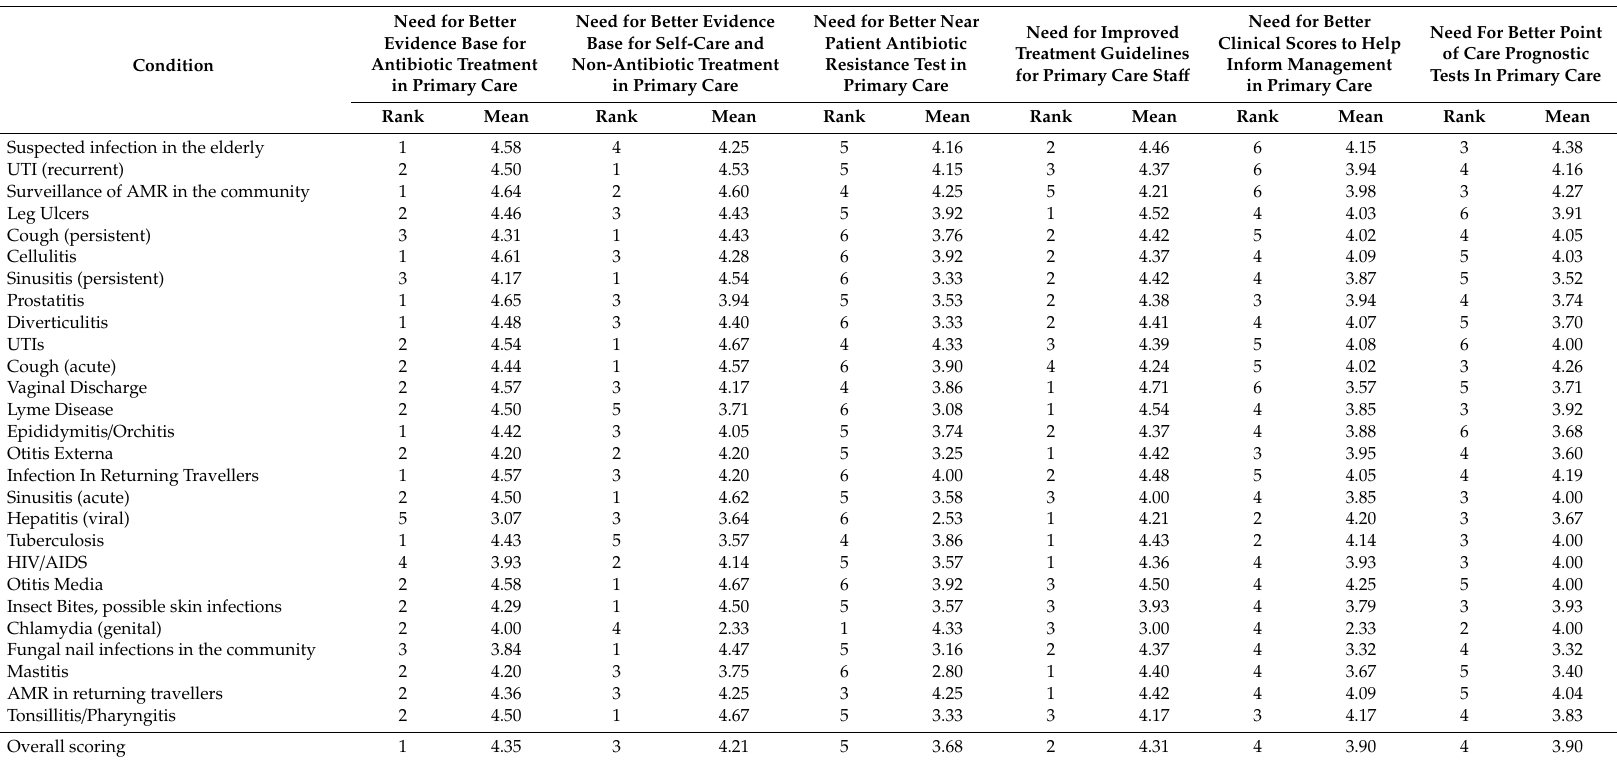
Table 3. Evidence, research and guidance needs, ranked in order of importance, for each named condition. Conditions are listed in order of importance for further research, as outlined in Table